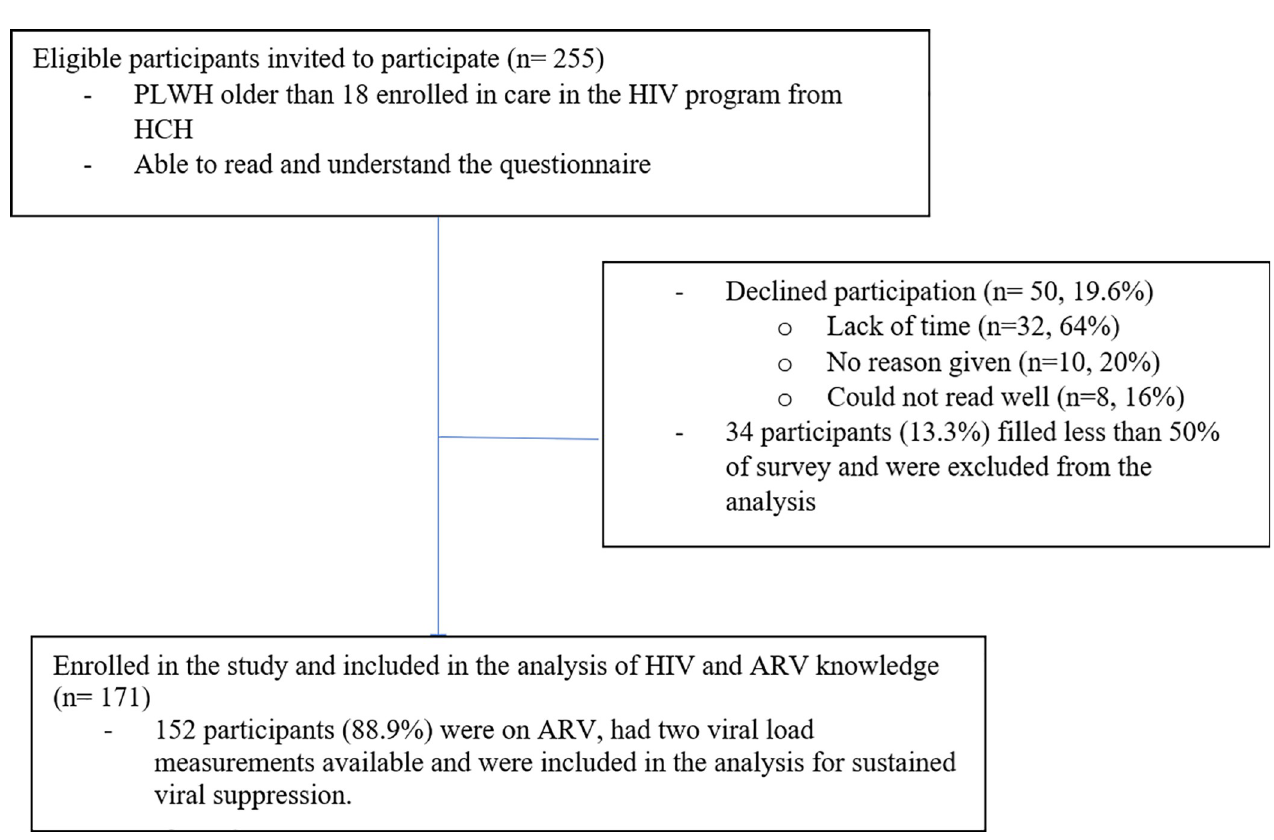
Fig 1. Study population, people living with HIV in a referral center in Lima, Peru,